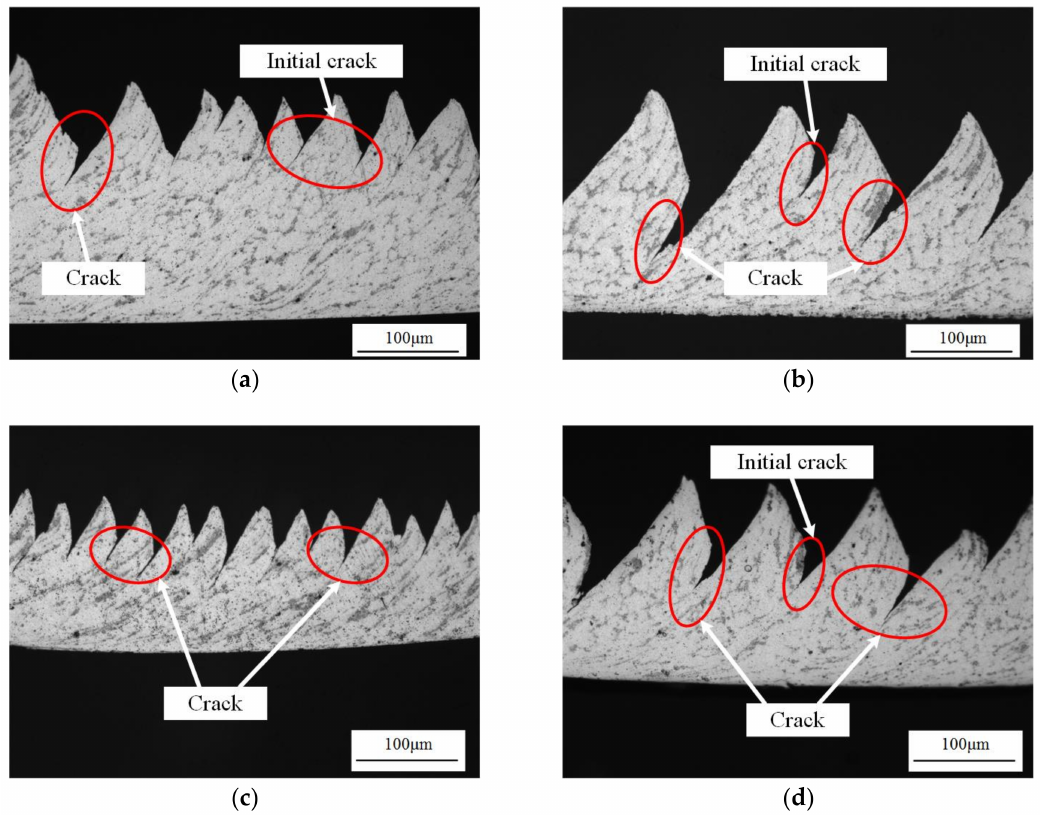
Figure 17. Cracks in the formed chips: ( a ) v s = 50 m/min, f r = 0.2 mm/r; ( b ) v s = 450 m/min, f r = 0.2 mm/r; ( c ) f r = 0.1 mm/r, v s = 150 m/min; ( d ) f r = 0.3 mm/r, v s = 150